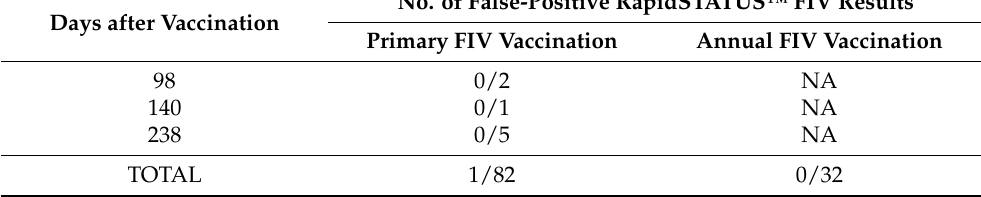
No. of False-Positive RapidSTATUS™ FIV